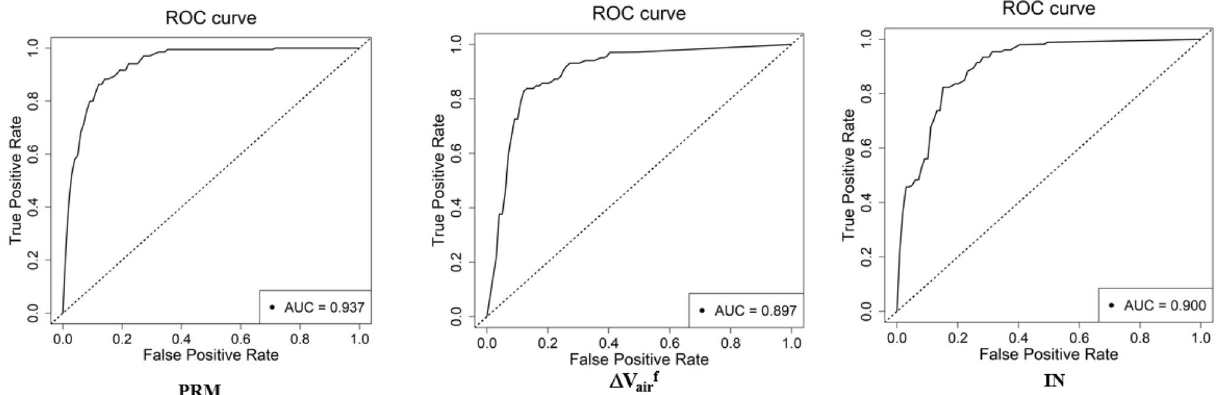
Figure 4. ROC curves of the COPD indices PRM, Δ V airf , and IN.